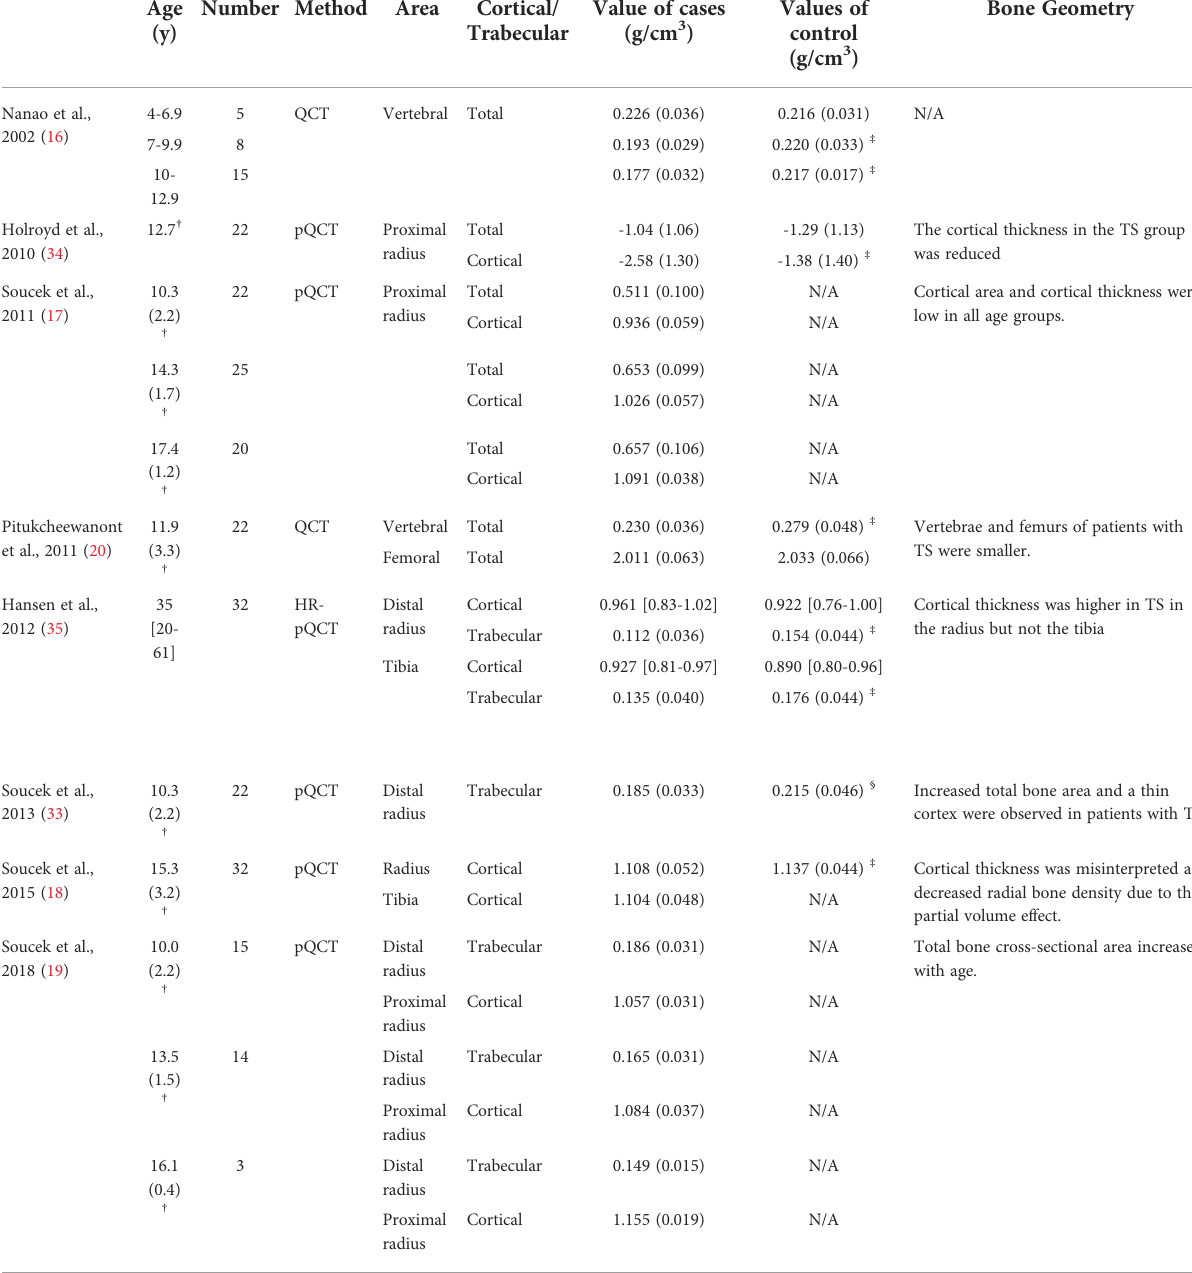
TABLE 1 Bone density and quality in TS according to QCT, pQCT, and